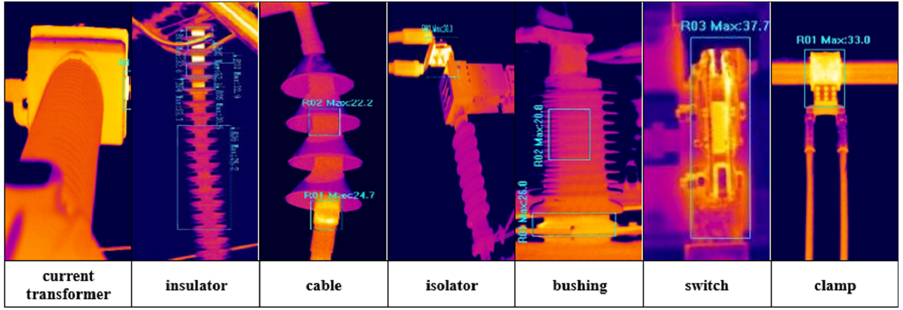
Figure 6. Seven types of power equipment.